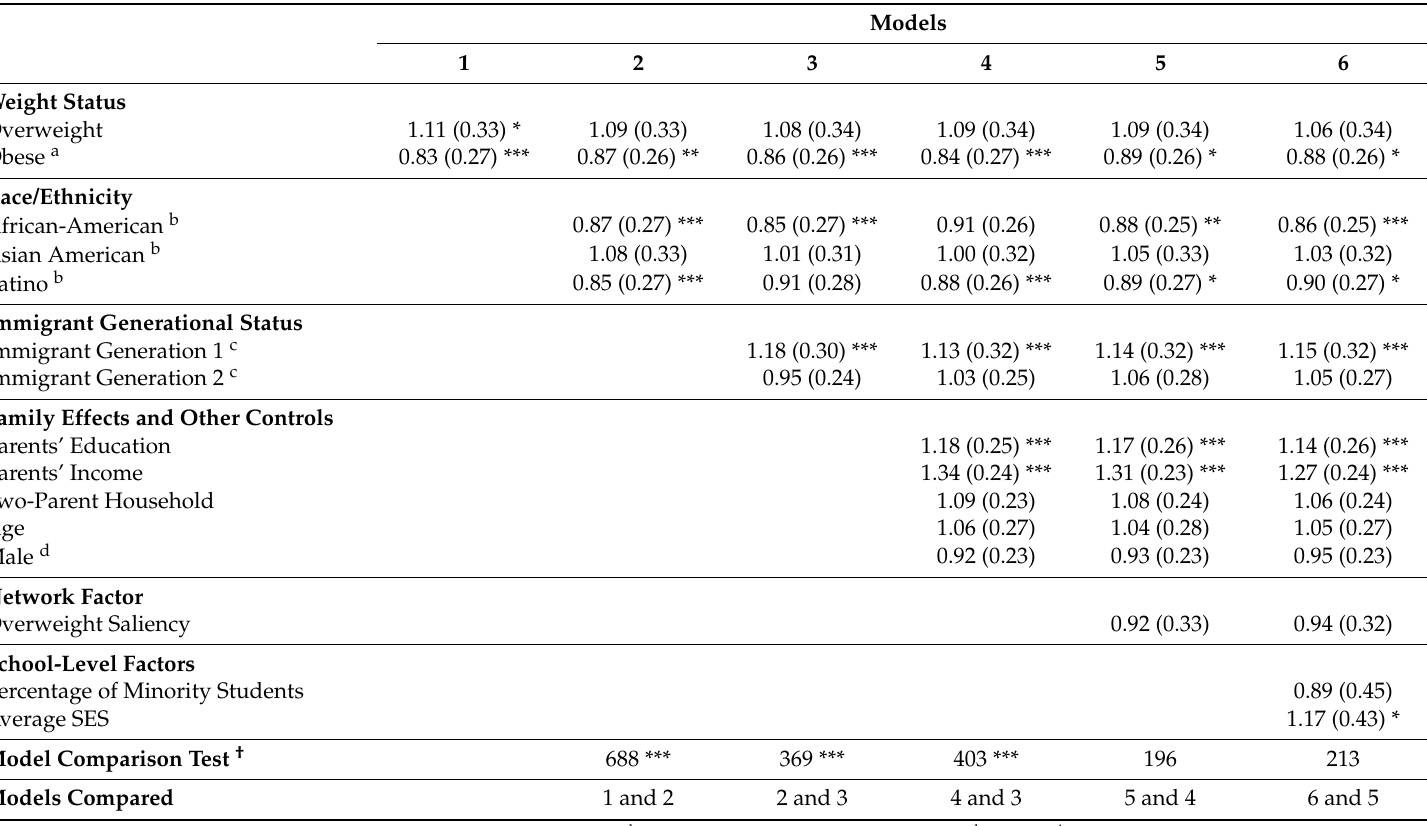
Table 3. Predictors of having some college education: odds ratios and their standard errors (in parenthesis).